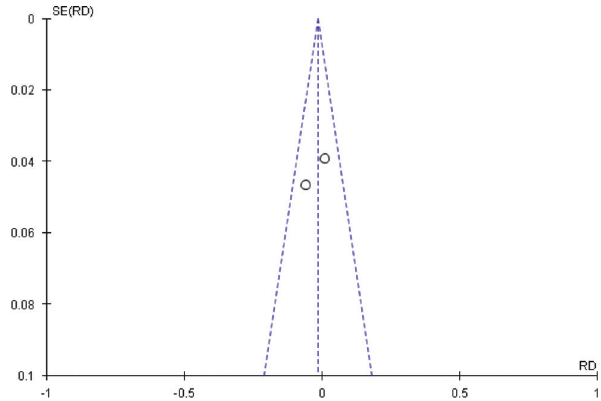
Figure 11 - Funnel plot of mortality related to procedures in randomized studies. All studies are inside the funnel